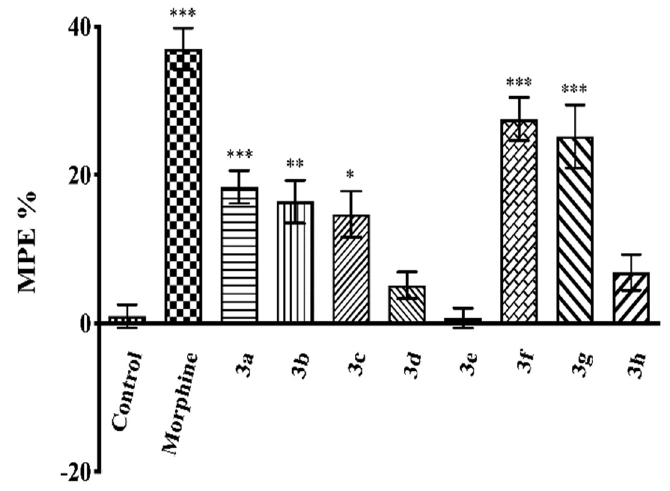
Figure 4. Effects of test compounds ( 3a – 3h , 50 mg/kg, p.o., administered 60 min before testing) and morphine (10 mg/kg, i.p., administered 30 min before testing) on MPE % values in the mice hot-plate test. Significance against control group * p < 0.05, ** p < 0.01, *** p < 0.001. Values are mean ± SEM. One-way ANOVA and post-hoc Tukey’s test, n = 7.